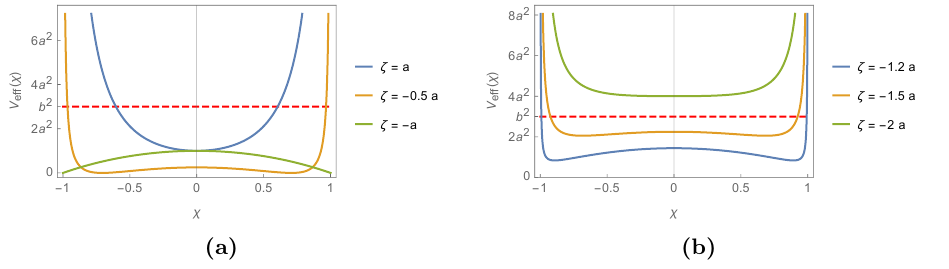
Figure 3. E(cid:11)ective potential V e(cid:11) ( (cid:31) ) for a BH with angular parameter a = 0 : 7, ‘ = 3: (a) Co-rotating and non-rotating geodesics (b) Counter-rotating